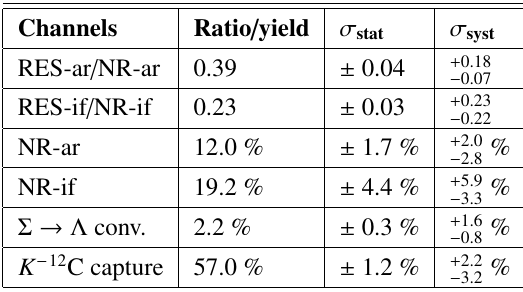
Table 1. Resonant to non-resonant ratios and amplitudes of the various channels extracted from the fit of the Λ π − sample. We indicate with RES and NR resonant and non-resonant processes respectively, the abbreviations ar and if are used for captures at-rest and in-flight. The statistical and systematic errors are also shown. See text for details.